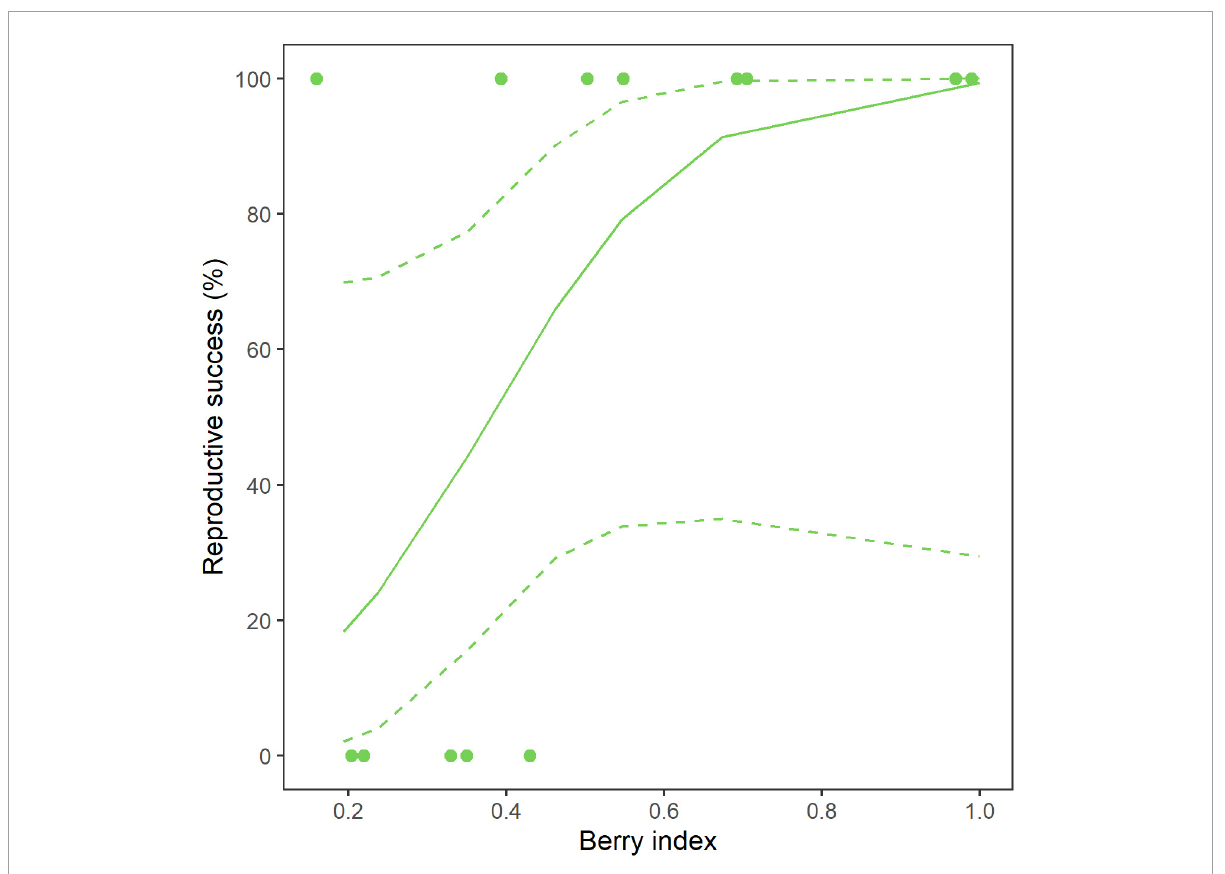
FIGURE5 Predicted probability to reproduce successfully for young adult Scandinavian brown bears ( N = 13) from the southern study area along the gradient of bilberry abundance in late summer during 2012–2018. The solid line represents the model predictions and the dashed lines the associated 95% confidence interval. The observations are shown as filled dots. We did not include adults in our model selection for predicting reproductive success because all adults had reproduced successfully in our